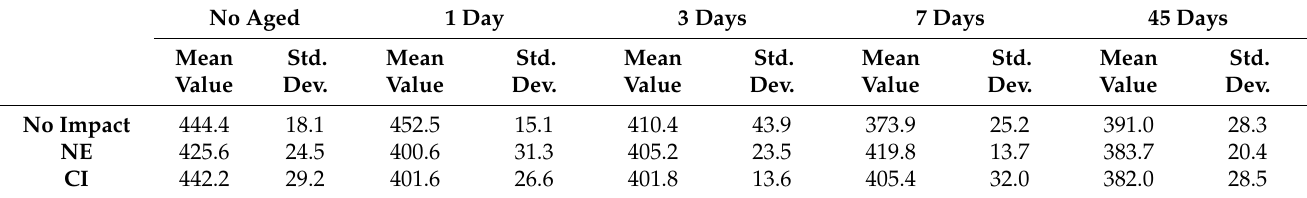
Table 4. Compressive residual strength results (values reported in [MPa]) .